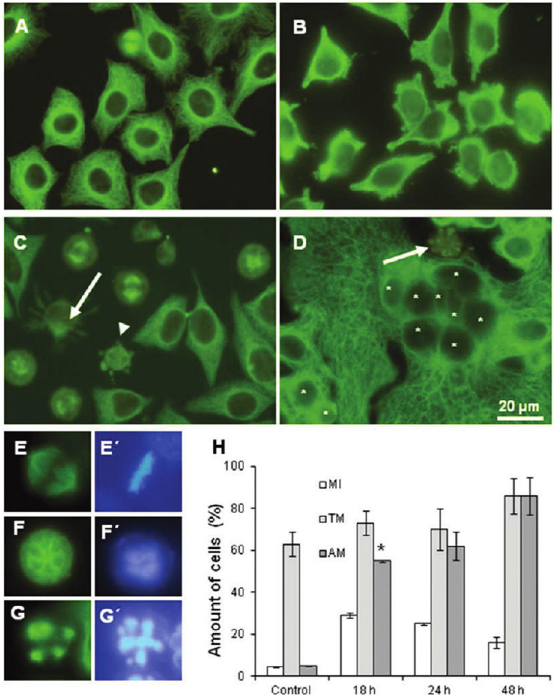
Figure 32 - Microtubule damage induced by Gal-Pht 39 . ( A ) Control HeLa cells showing a well-developed network of MTs determined by tubulin immunolabeled and observed by fluorescence microscopy. Three hours after phototreatment (5 × 10 −7 M of Gal-Pht 39 for 4 h and 15 min of red light irradiation) retraction and disorganization of MTs of cells in interphase could be observed ( B ). At 24 h after phototreatment ( C ) cells in metaphase showed abnormal mitotic spindles (arrow) as well as cells in apoptosis (arrowhead). At 48 h after phototreatment ( D ), giant polyploid and multinucleated (asterisks) cells appeared. ( E−G ) Details of a control ( E ) and abnormal mitotic spindles of HeLa cells 24 h after phototreatment ( F,G ). ( E′−G′ ) The chromosomes stained with H-33258 perfectly aligned in the control ( E′ ) or dispersed in the treated metaphase cells ( F′,G′ ). Scale bar: 20 μm . ( H ) Cell blockage at 18, 24, and 48 h induced after photodynamic treatment with Gal-Pht 39. MI, mitotic index; TM, total metaphases; AM, abnormal metaphases; data correspond to mean values ± standard deviation from three independent experiments (*p < 0.05). Reproduced from Soares et al. 2012 with permission of The American Chemical